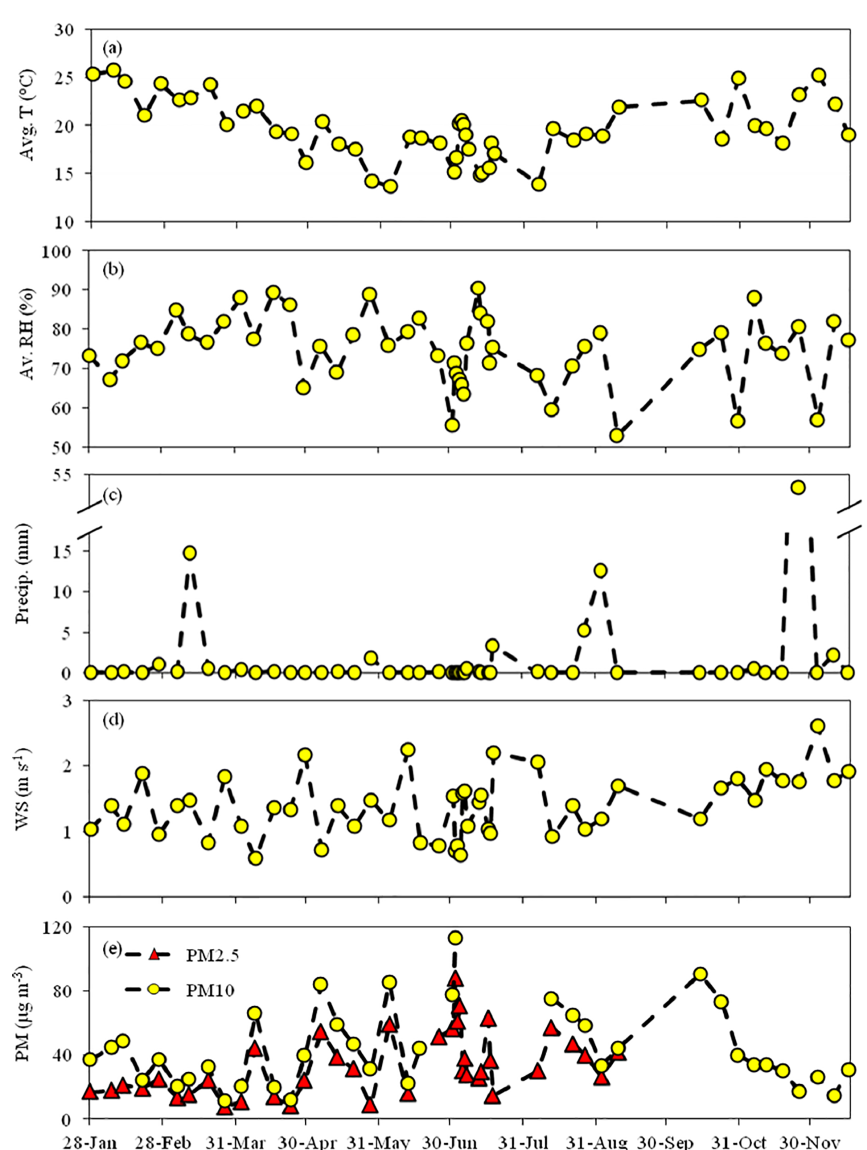
Figure 2. (a) Daily average temperatures, (b) relative humidity (RH), (c) precipitation, (d) wind speed, and (e) PM 10 and PM 2 . 5 concentra- tions for the three